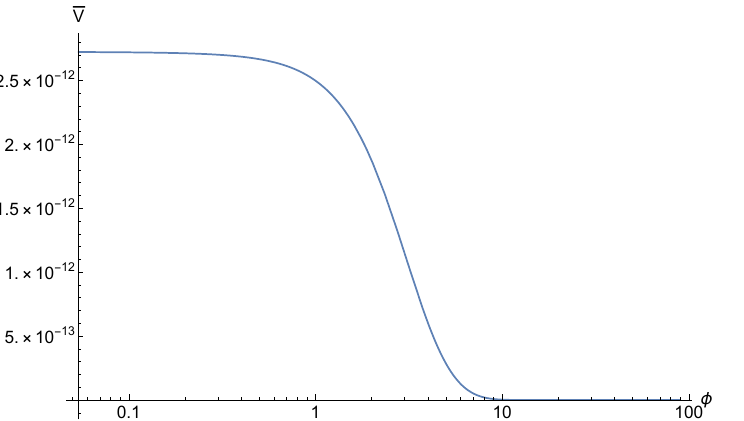
Figure 1. The scalar potential ¯ V in Planck units in the Einstein frame, featuring the inflationary plateau and the quintessential